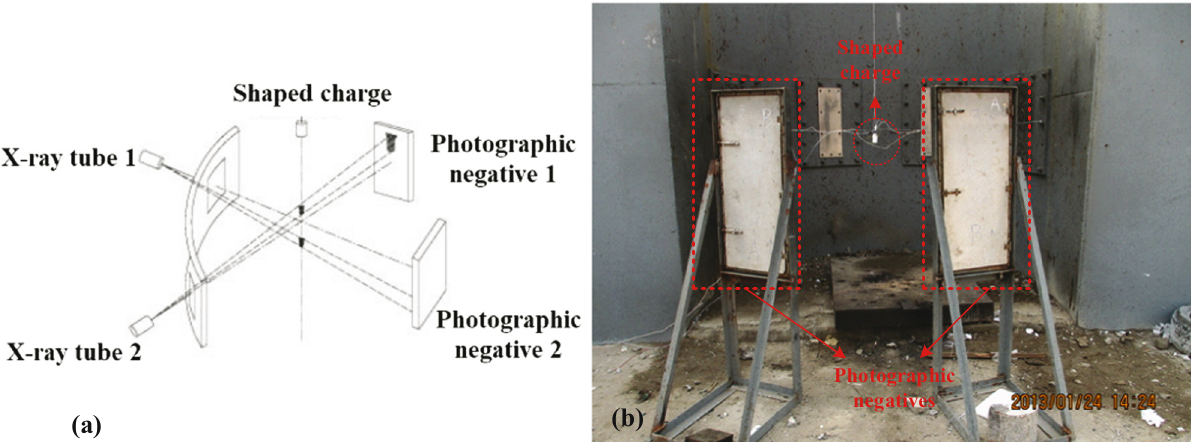
Figure 2: Field layout of the pulse X - ray test: ( a ) pulse X - ray test principle and ( b ) test layout.